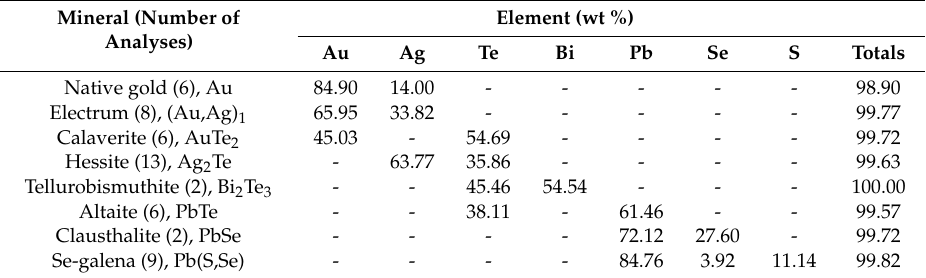
Note: “-“, not detected.